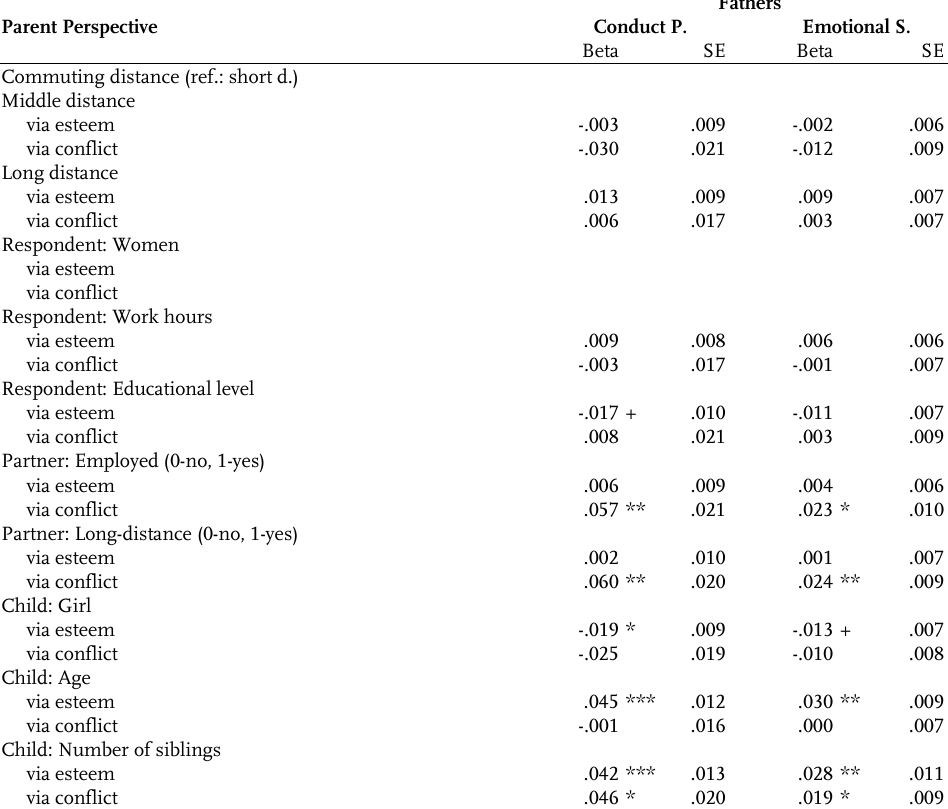
Fathers Beta SE Beta SE